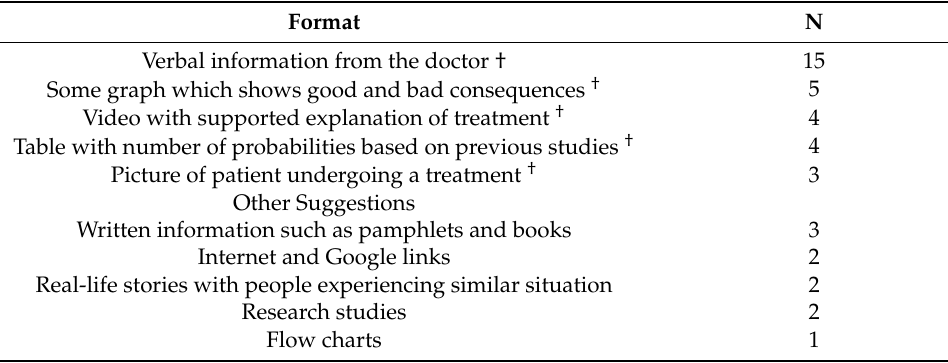
Table 3. Delivery format of prognostic information from clinician.